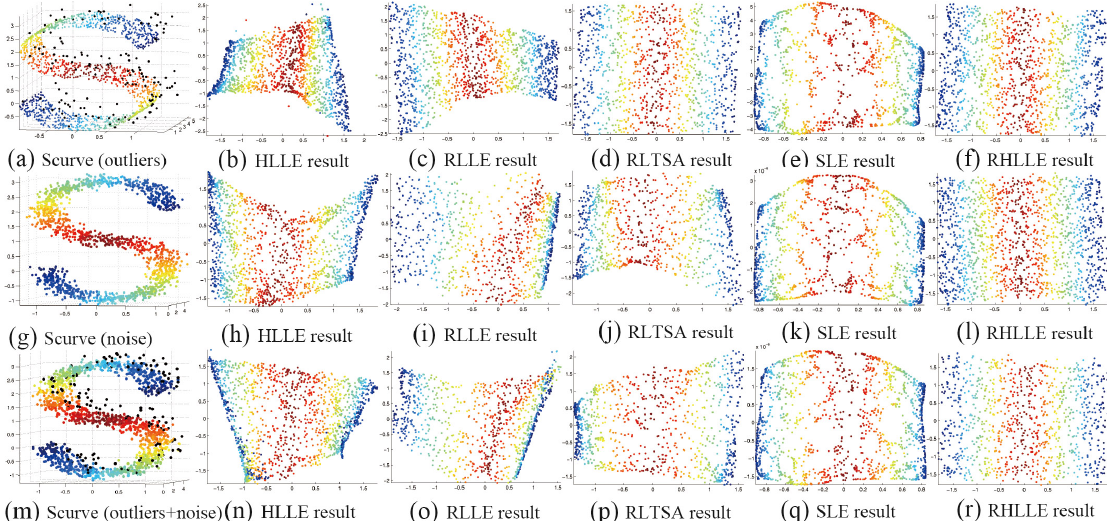
Figure 4. The first row shows the S-curve dataset with outliers and the embedding results of different algorithms; The second row shows the S-curve dataset with noise and the embedding results of different algorithms; The third row shows the S-curve dataset with both outliers and noise and the embedding results of different